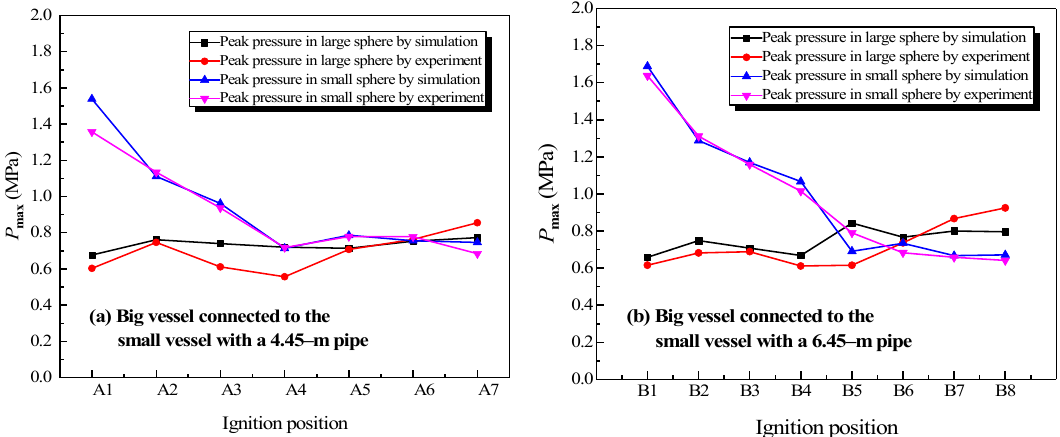
Figure 14. Comparison between the simulation data and experimental data of the natural gas explosion pressure versus time in the linked vessels.